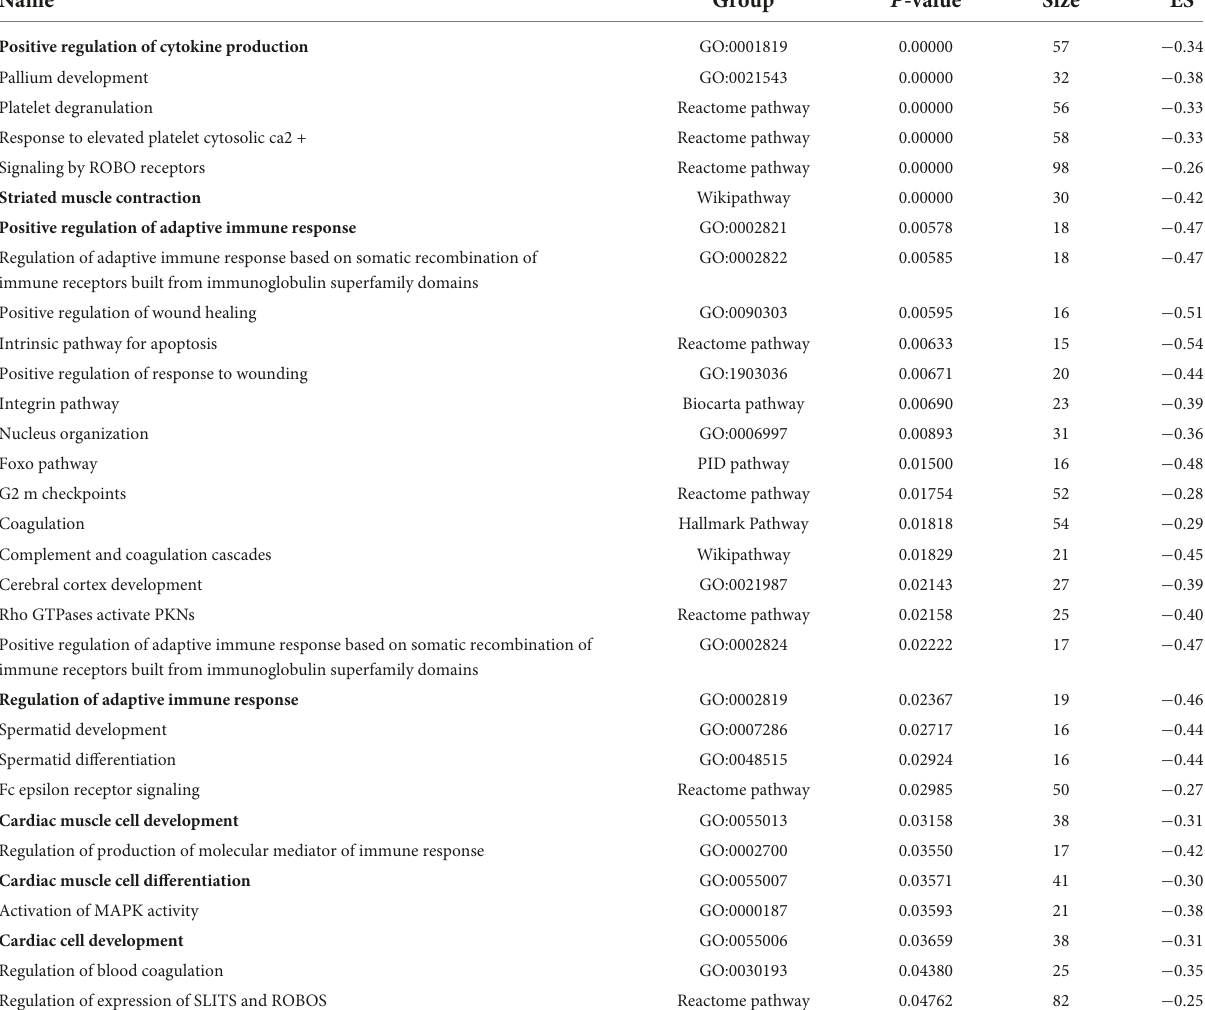
TABLE 2 Biological annotations terms enriched in significantly up-regulated proteins of the proteome